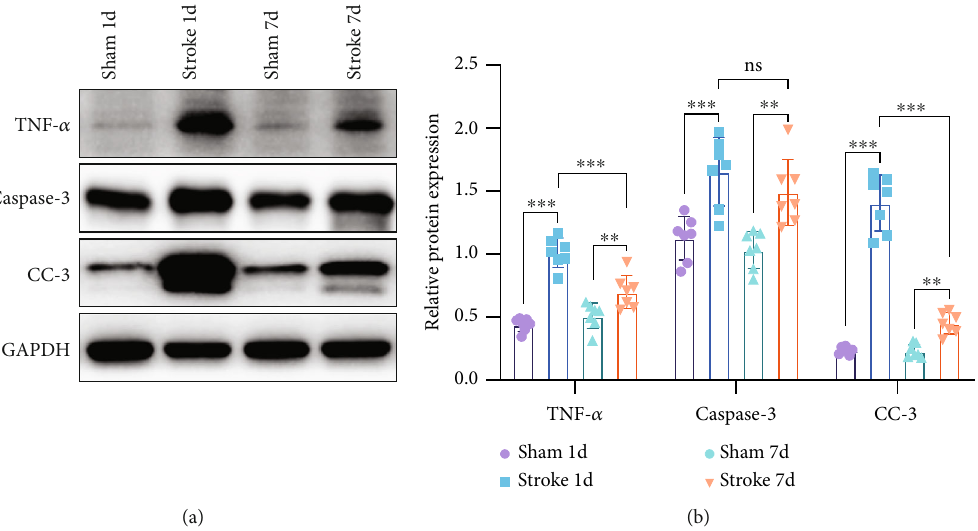
Figure 6: Ischemic stroke promotes apoptosis of the small intestine. (a, b) Representative western blots and quanti fi cation data of TNF- α , caspase-3, cleaved caspase-3, and GAPDH for each group ( n = 7 ). Data were expressed as mean ± standard deviation . ∗∗ p < 0 : 01 , ∗∗∗ p < 0 : 001 (two-way ANOVA with Tukey ’ s multiple comparison test). ns: not signi fi cant; CC-3: cleaved